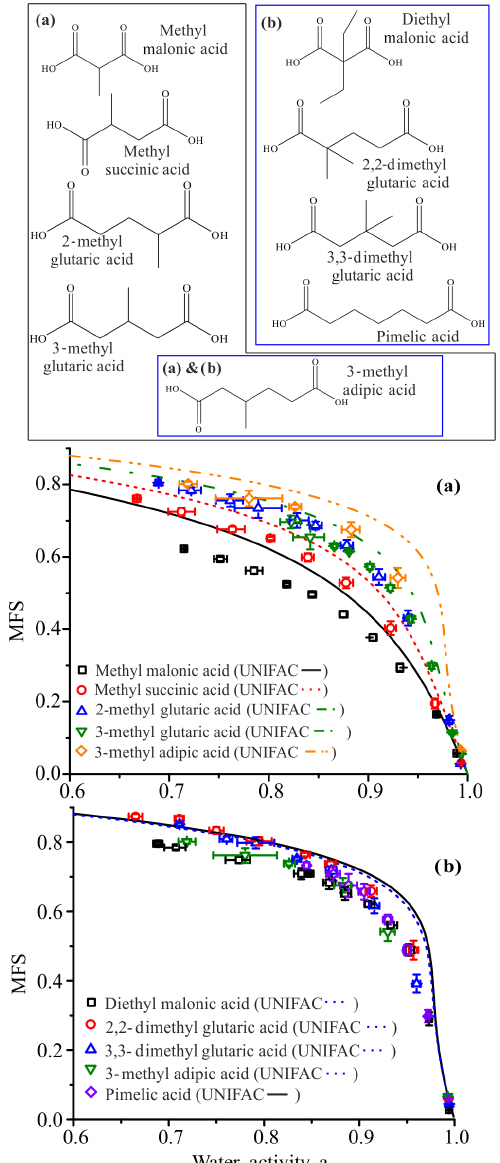
Figure 5. Equilibrium hygroscopicity curves for a series of branched dicarboxylic acids are shown in (a) . In (b) CK-EDB hygroscopicity curves for a series of dicarboxylic acids with the same O:C ratio of 0.57. UNIFAC prediction using AIOMFAC- web. In (b) the AIOMFAC-web prediction for 3-methyl adipic acid, [(CH 3 ) (CH)(CH 2 ) 3 (COOH) 2 ], and 3,3-dimethylglutaric acid, [(CH 3 ) 2 (C)(CH 2 ) 2 (COOH) 2 ], 2,2-dimethylglutaric acid, [(CH 3 ) 2 (C)(CH 2 ) 2 (COOH) 2 ], is represented by the dashed blue line. Note that the equilibrium curves for the first four compounds are in such close agreement and indistinguishable on this scale that only one curve is shown for clarity. The prediction for pimelic acid [(CH 2 ) 5 (COOH) 2 ] is shown as a solid black